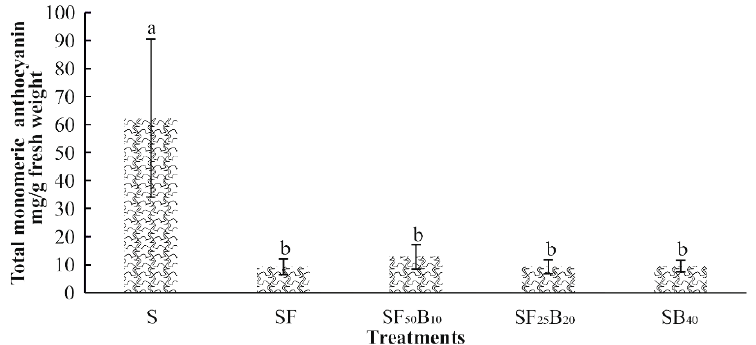
Figure 6. Anthocyanins content in basil ( Ocimum basilicum L.) cultivated in a soil with treatments, S, soil without fertilizer (control); SF, soil + fertilizer (N:P:K 100:40:40); SF 50 B 10 , soil + fertilizer (N:P:K, 50:20:20) + biosolid (10 t ha −1 ); SF 25 B 20 , soil + fertilizer (N:P:K, 25:10:10) + biosolid (20 t ha −1 ) and SB 40 , soil + biosolid (40 t ha −1 ). Means ± standard error, bars with different letters are significantly different according to LSD test ( p < 0.05).